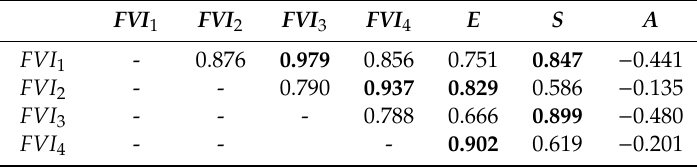
Table 3. The comparison of relationships between each two di ff erent flood vulnerability indicators, and between flood vulnerability indicators and primary assessment components, measured by the coe ffi cient of